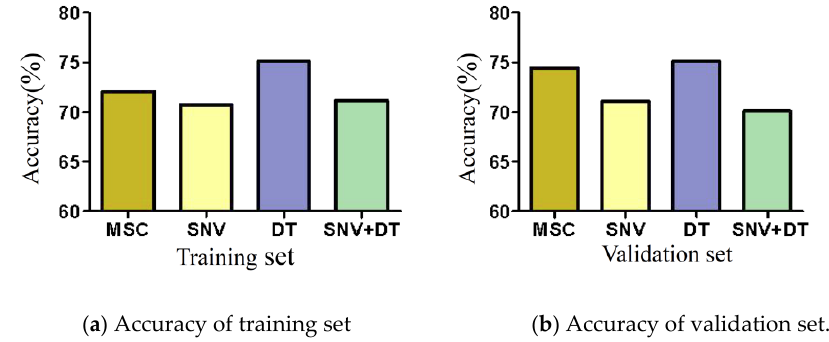
Figure 4. Model classification accuracy of different preprocessing methods.